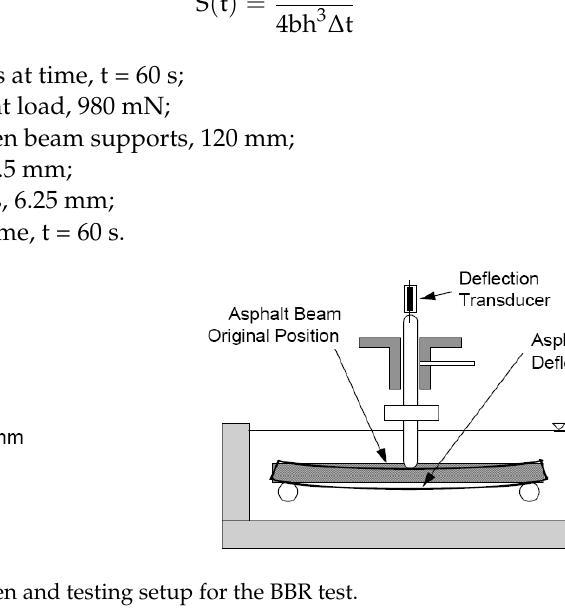
Table 9. BBR test results (creep stiffness and m-value) for